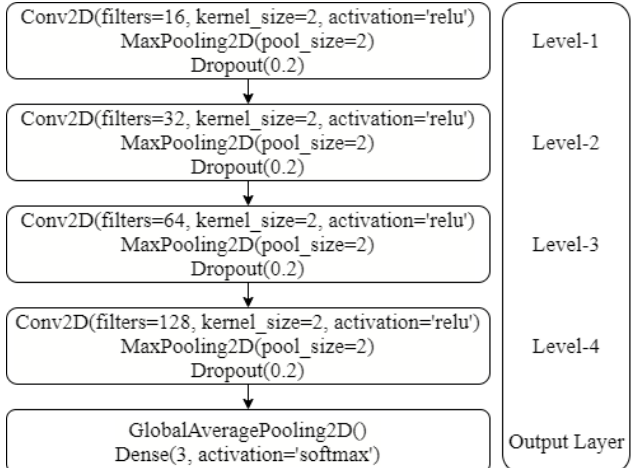
Figure 11. Architecture of CNN model used for experiments in this study. Conv2D shows the 2D convolutional layer with kernel size of 2 and max pooling layer with a pool size of 2. Dropout rate for neuron drop is 0.2 indicating 20% drop for